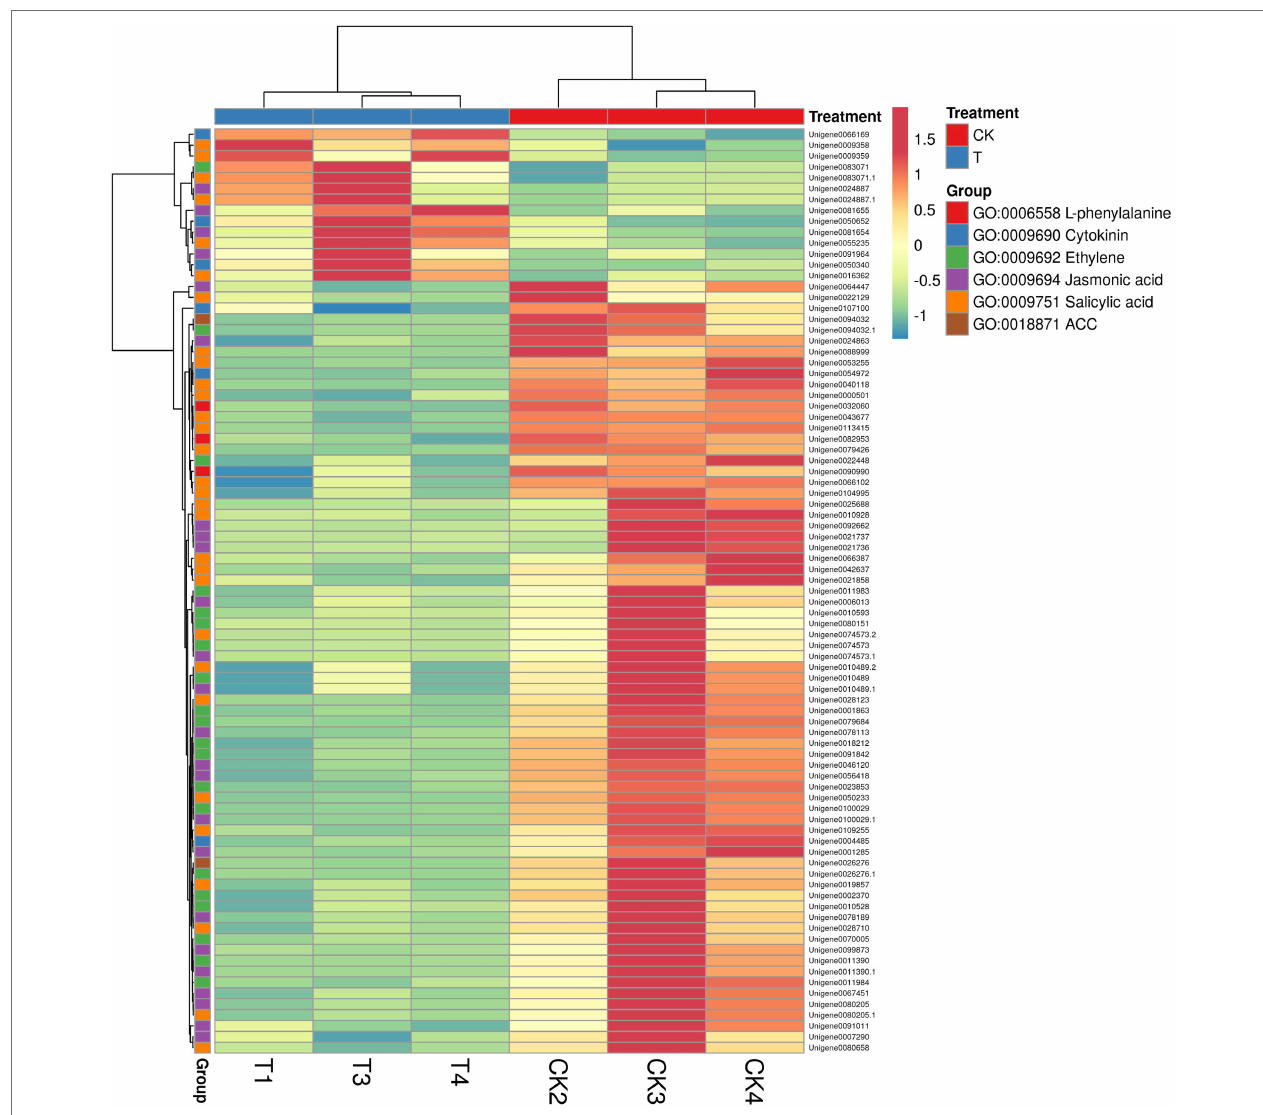
FIGURE 10 | The heat map representation of genes involved in phytohormone metabolism. The expression values are RNA-seq FPKM